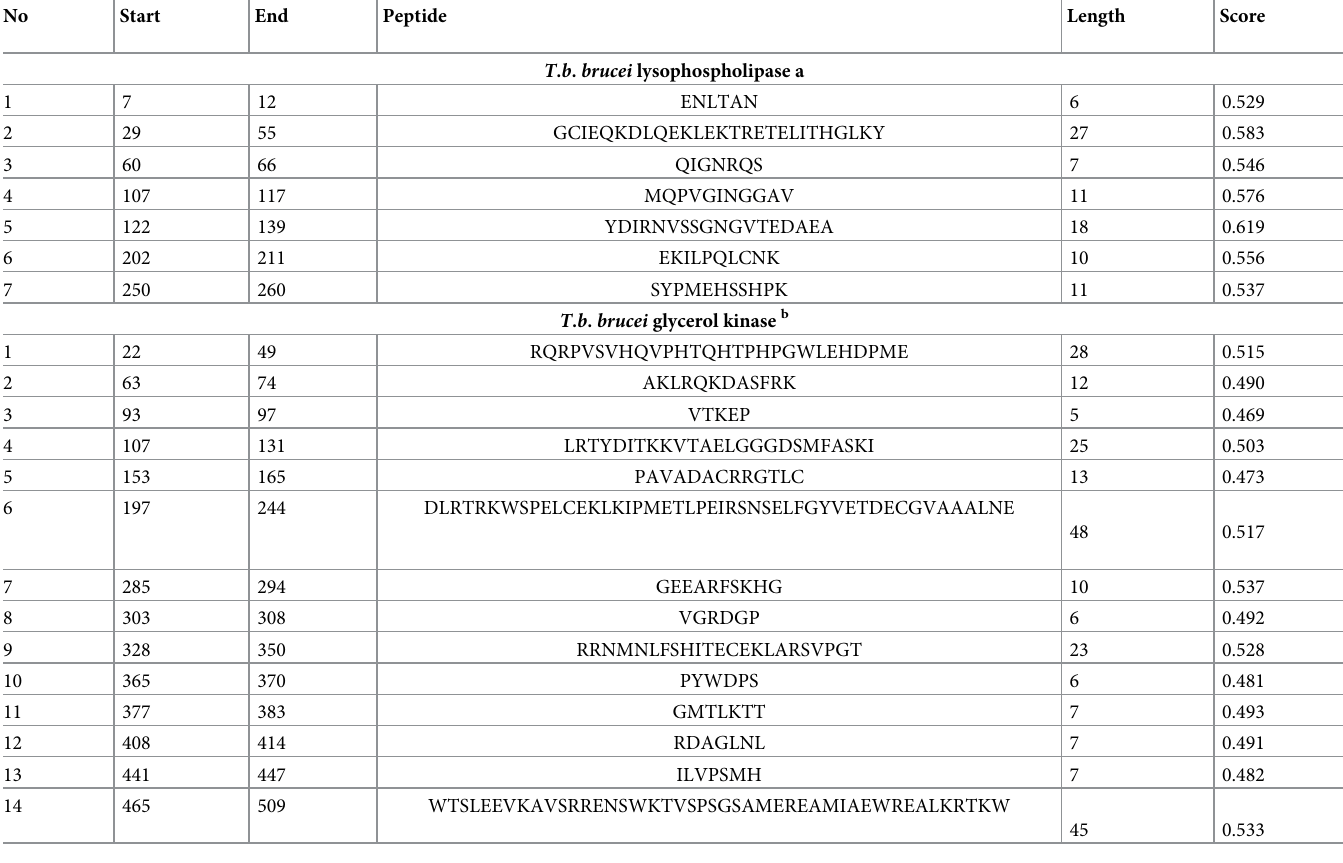
Table 2. Antigenic peptides of TbLysoPLA and TbGK predicted using BepiPred-2.0